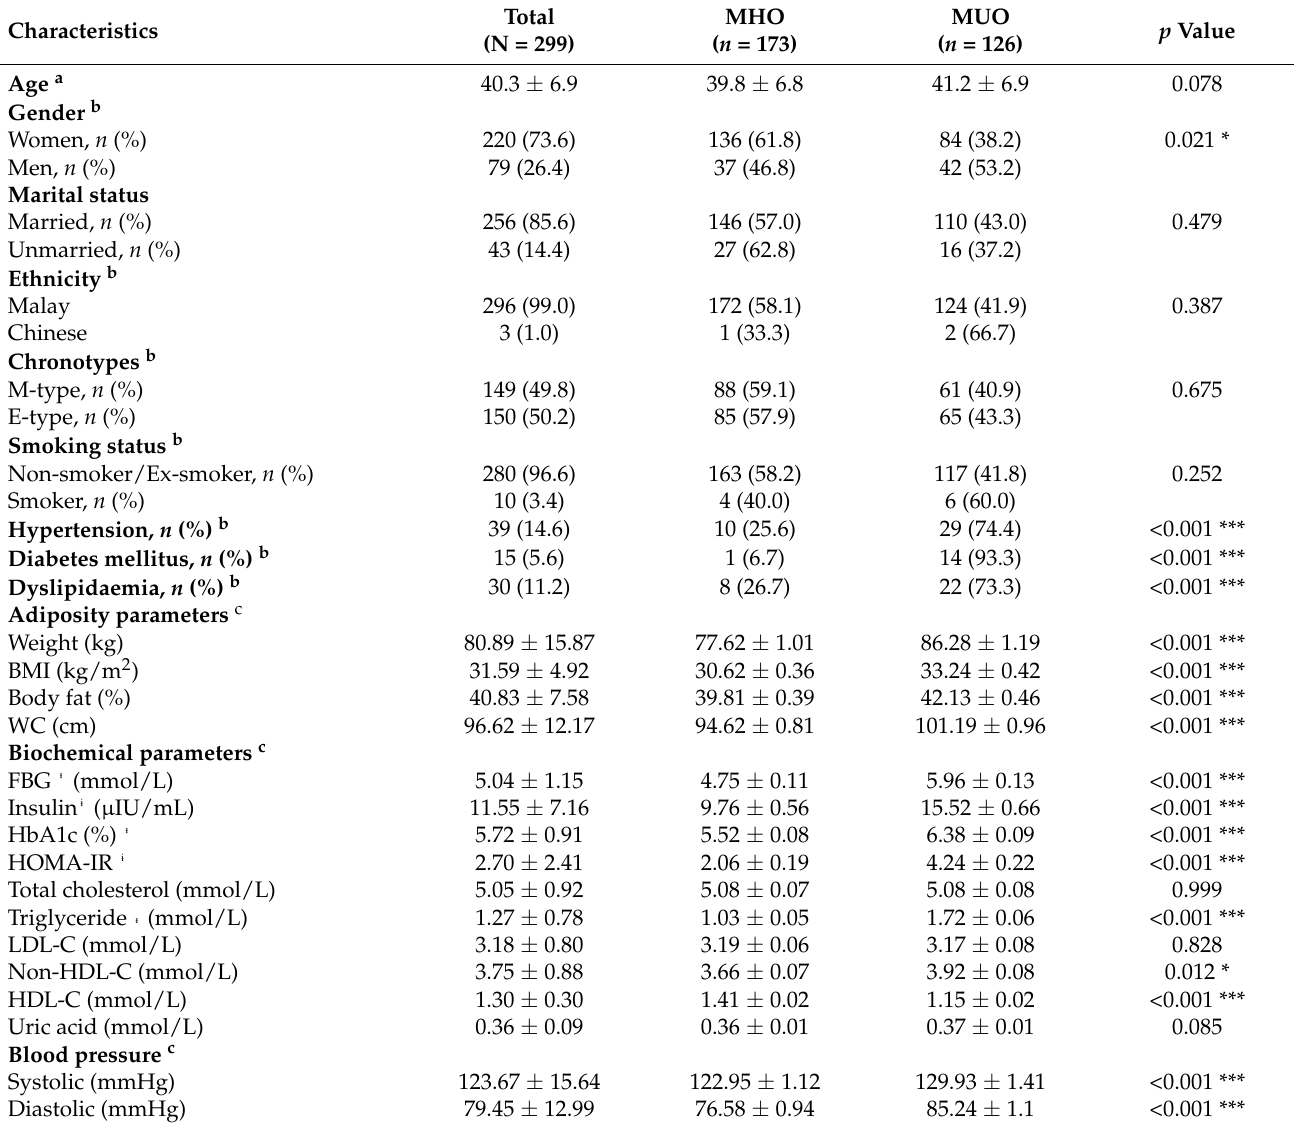
a Data are shown as mean ± standard deviation according to independent t -test. b Data are shown as number (%) according to Chi-square test. c Data are shown in mean ± standard error according to ANCOVA test, adjusted for age and gender. Table 2. Lifestyle characteristics and dietary intake of MHO and MUO. Characteristics